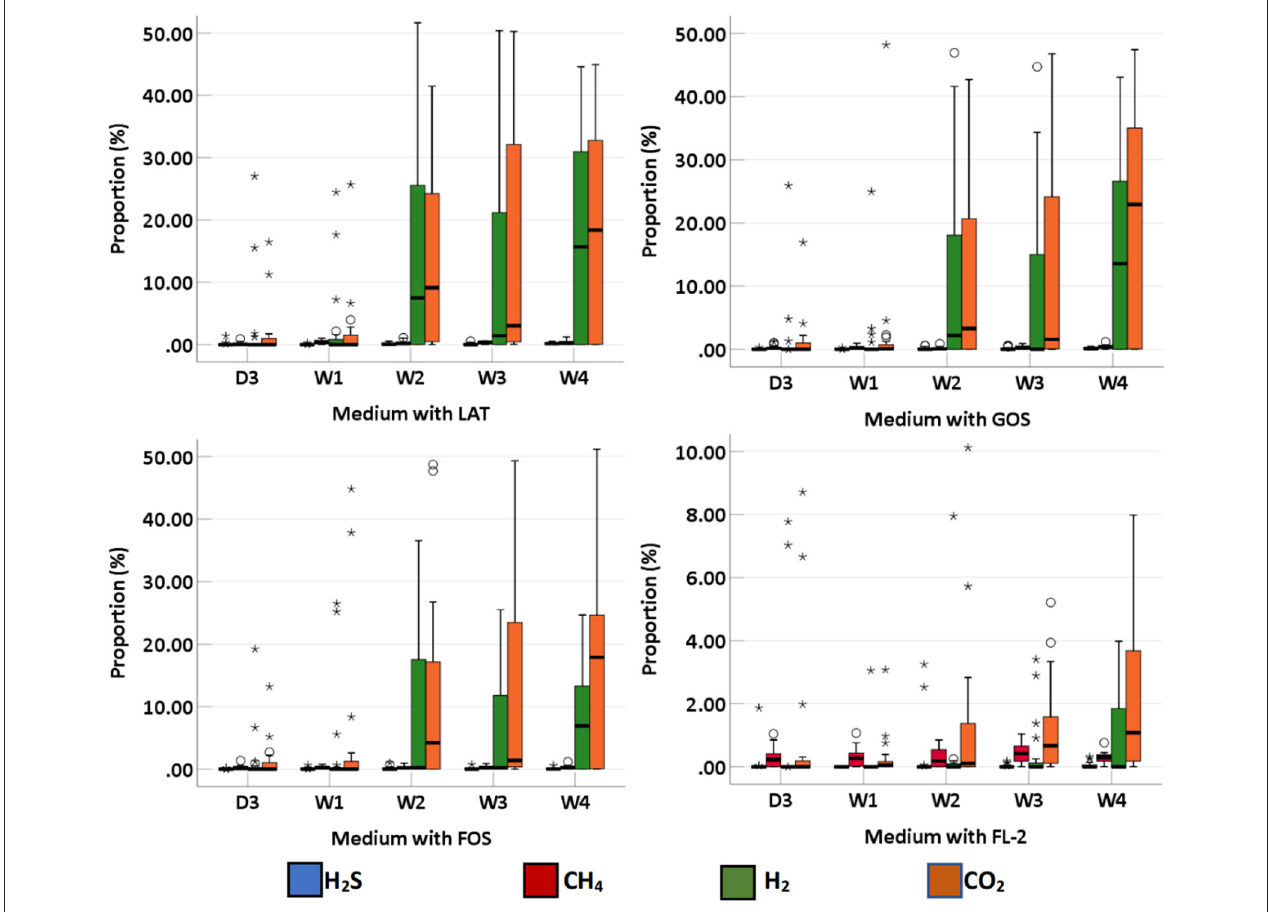
FIGURE 2 | The proportion of intestinal gas composition (CO 2 , H 2 , CH 4 , and H 2 S) of preterm infants of different ages. D3, 3 days after birth; W1, 1 week after birth; W2, 2 weeks after birth; W3, 3 weeks after birth; W4, 4 weeks after birth; LAT, lactose; FOS, fructooligosaccharide; FL-2, milk oligosaccharide; GOS, galactooligosaccharide; *, extreme value; ◦ , discrete